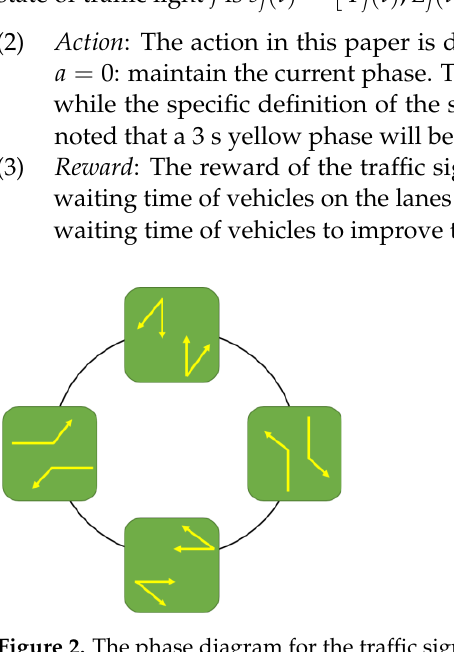
Figure 2. The phase diagram for the traffic signals in this paper.